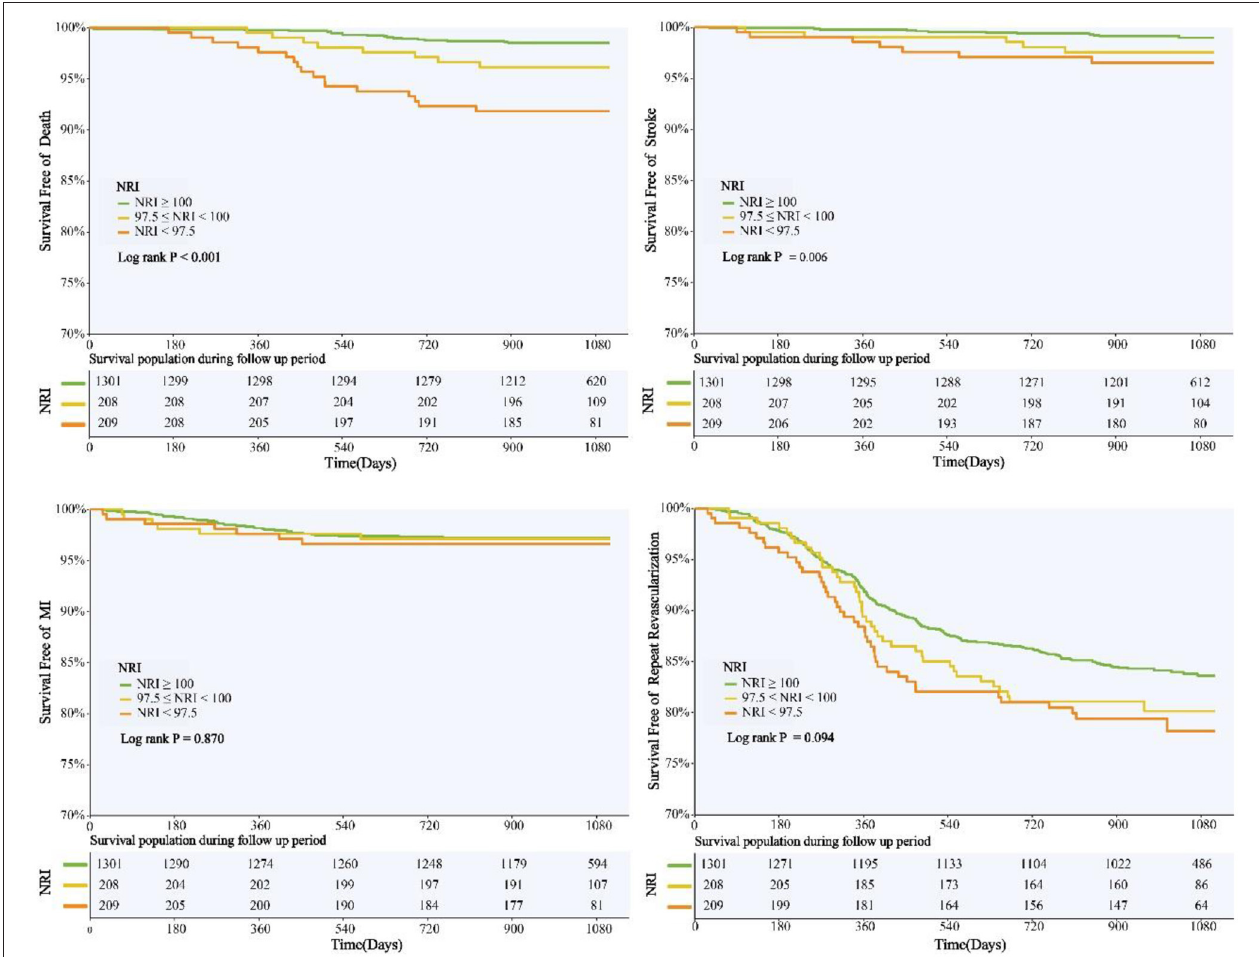
FIGURE 4 | NRI Degree and Risk of Death, Stroke, MI, and Revascularization. Kaplan-Meier curves for all-cause death, non-fatal stroke, non-fatal myocardial infarction, and unplanned repeat revascularization by the NRI degree. NRI, nutritional risk index; MI, myocardial